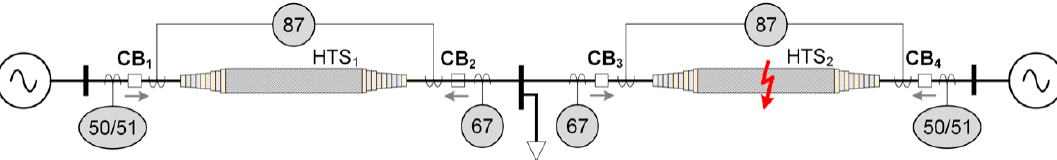
Figure 9. Tested Figure 9. Tested system.